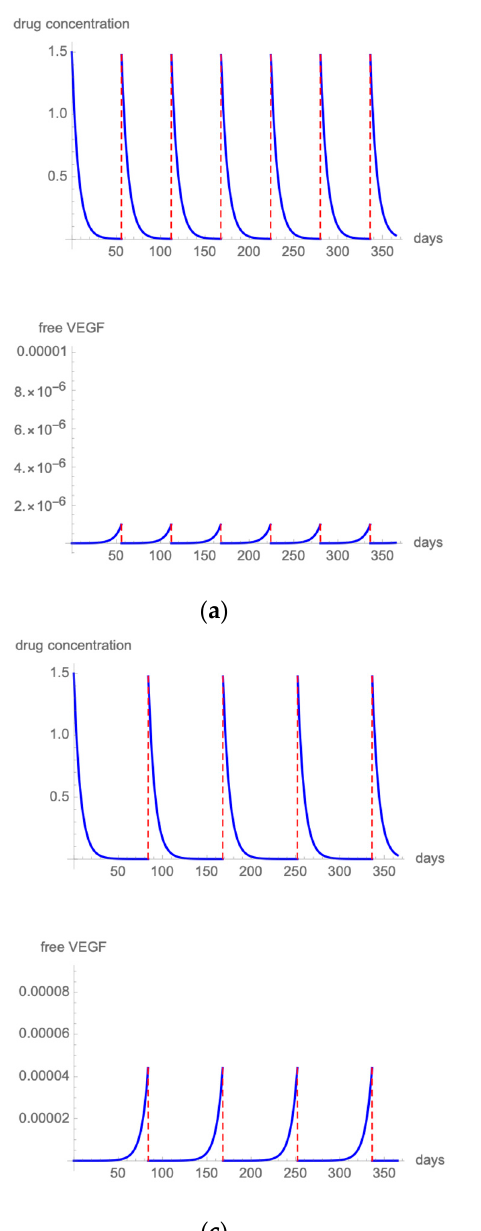
Figure 5. Figure 5 illustrates the intravitreal drug concentration and free VEGF proportion in a pa- tient treated with q8 ( a ), q10 ( b ), or q12 ( c ) 6 mg brolucizumab